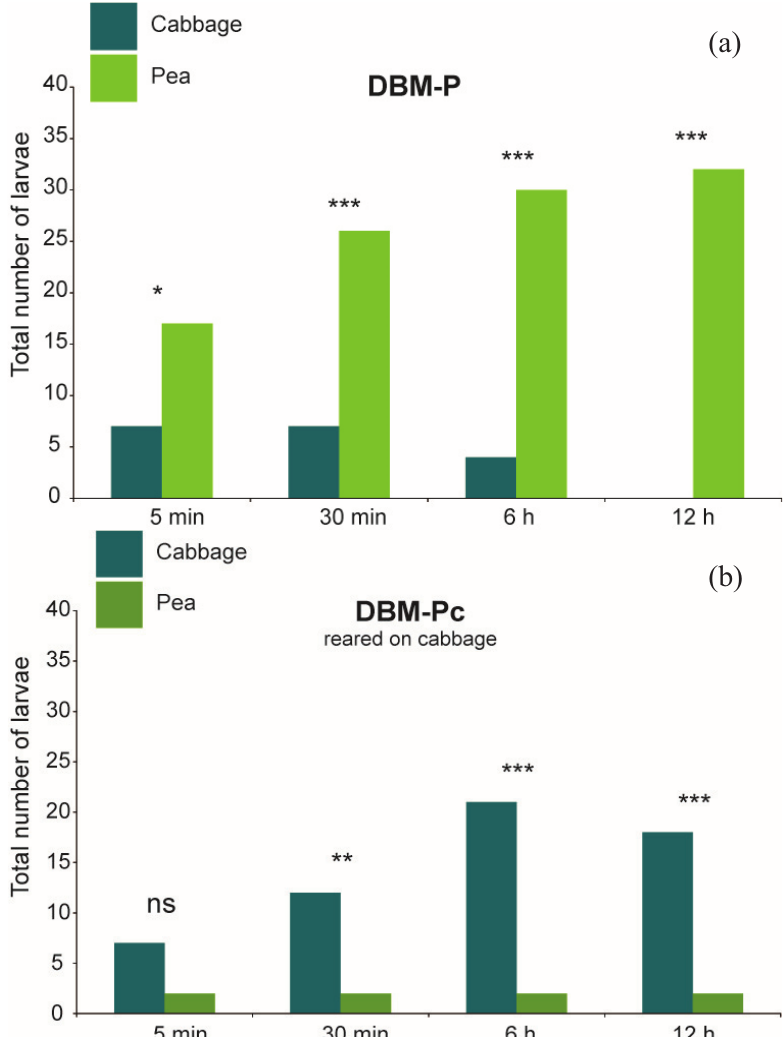
Figure 2. ( a ) Orientation choice of L4 larvae of DBM-P ( n = 38); ( b ) DBM-P reared on cabbage ( n = 30); ( c ) DBM-Cj ( n = 40) after 5 min, 30 min, 6 h and 12 h. ** p < 0.01, *** p < 0.001, ns = not